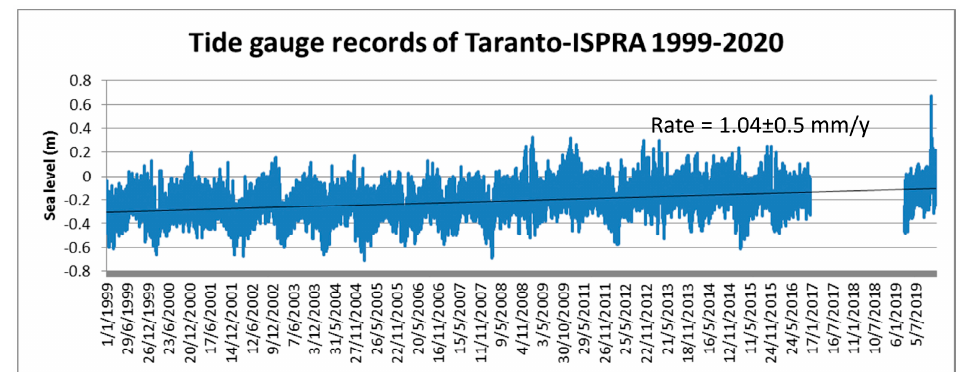
Figure 4. Sea-level time series for the Taranto station in the time span 1999–2020, recorded at a 10-minute sampling rate. The black line is the linear fit of the data that provide a sea-level rate of 1.04 ± 0.5 mm/year. Water 2020 , 12 , x FOR PEER REVIEW